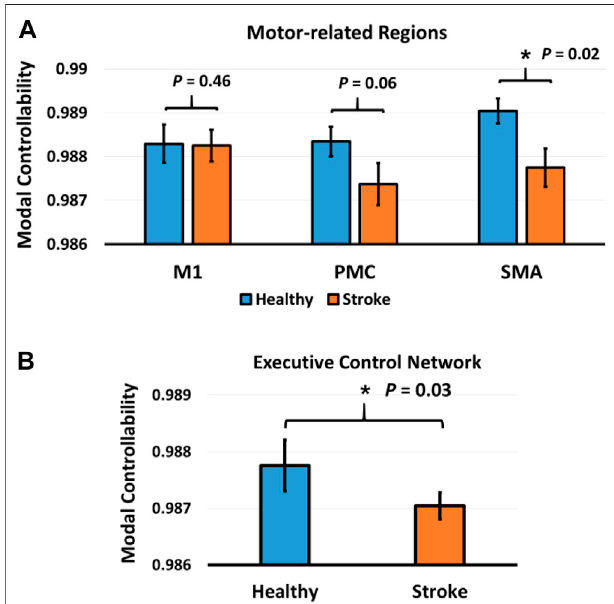
FIGURE 4 | (A) Comparison of modal controllability in M1, PMC, and SMA between stroke patients and healthy subjects. (B) Comparison of modal controllability in executive control network (ECN) between stroke patients and healthy subjects. Asterisk represents signi fi cant difference ( p < 0.05) after multiple comparison